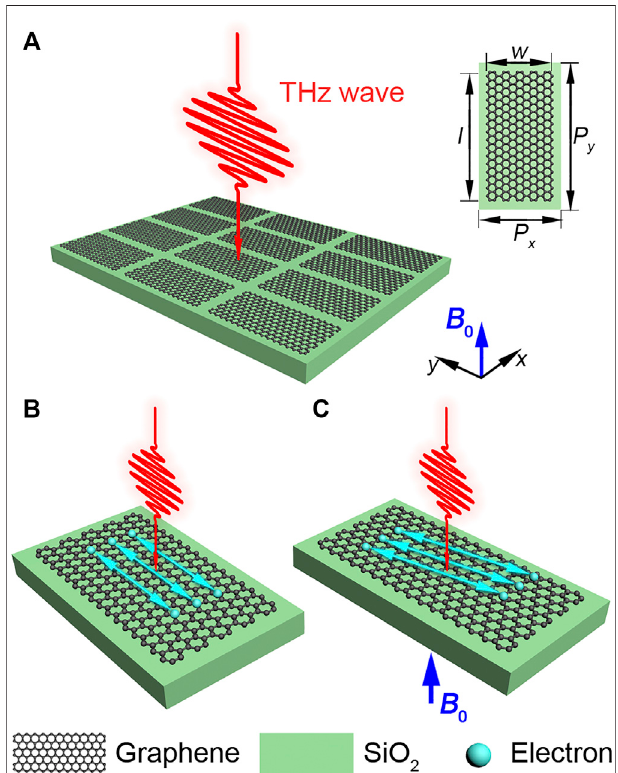
FIGURE 1 | (A) Schematic diagram of the proposed terahertz metasurface consisting of periodically arranged graphene cut-wire resonators.Thestructuralparameters: P x (cid:2) 250 μ m, P y (cid:2) 500 μ m, l (cid:2) 450 μ m, w (cid:2) 210 μ m, and the SiO 2 substrate has thickness h (cid:2) 50 μ m. Conceptualschematicdiagramoftheoscillationoftheelectronsintheunitcell (B) without or (C) with the external magnetostatic fi eld applied. When the magnetostatic fi eld bias is applied, the electron oscillation path along the y -axis in the unit cell is de fl ected at a certain angle.